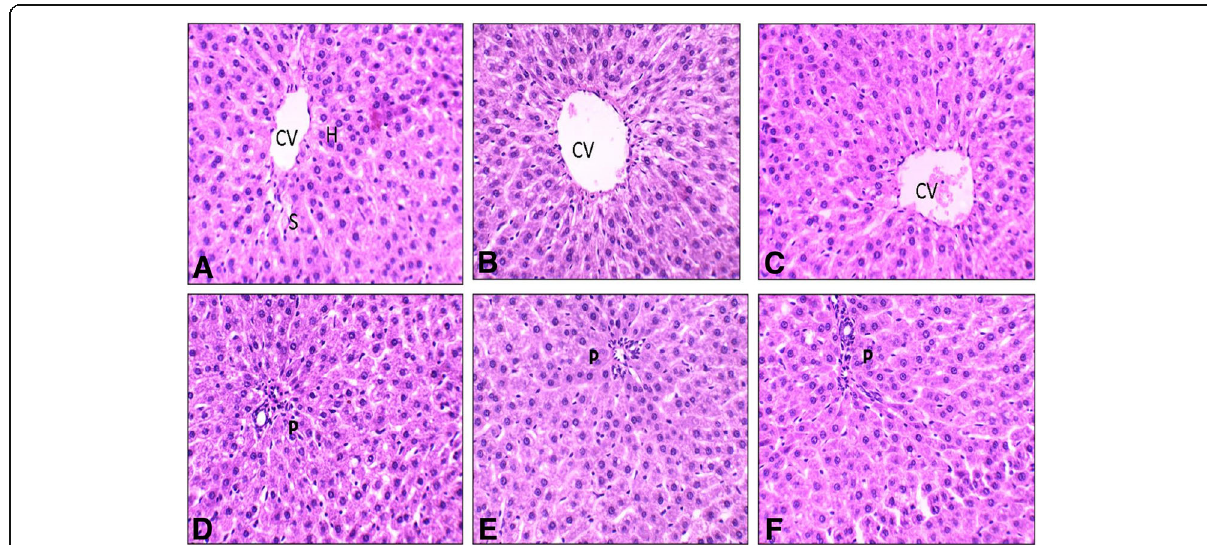
Fig. 1 a Liver section of a control rat showing hepatic cell (H), central vein (CV), and hepatic sinusoid (S) with Kupffer cell. b Liver section of a rat treated with corn oil showing normal hepatic cell surrounding the central vein (CV). c Liver section of a rat treated with curcumin extract showing normal hepatic cell surrounding the central vein (CV). d Liver section of a control rat showing the normal histological appearance of the portal area (P). e Liver section of a rat treated with corn oil showing the normal histological appearance of the portal area (P). f Liver section of a rat treated with curcumin extract showing the normal histological appearance of the portal area (P). (H&E stain, ×400)